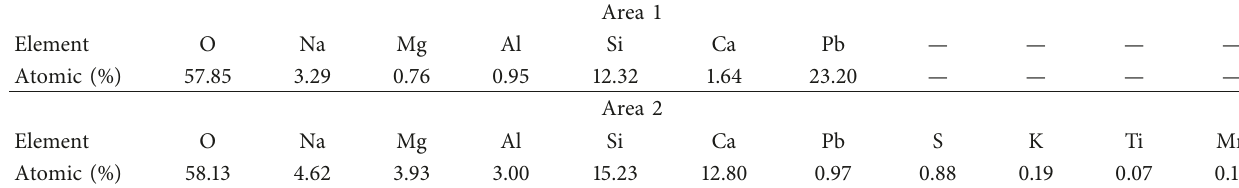
Table 7: EDS analysis of S2 matrix.